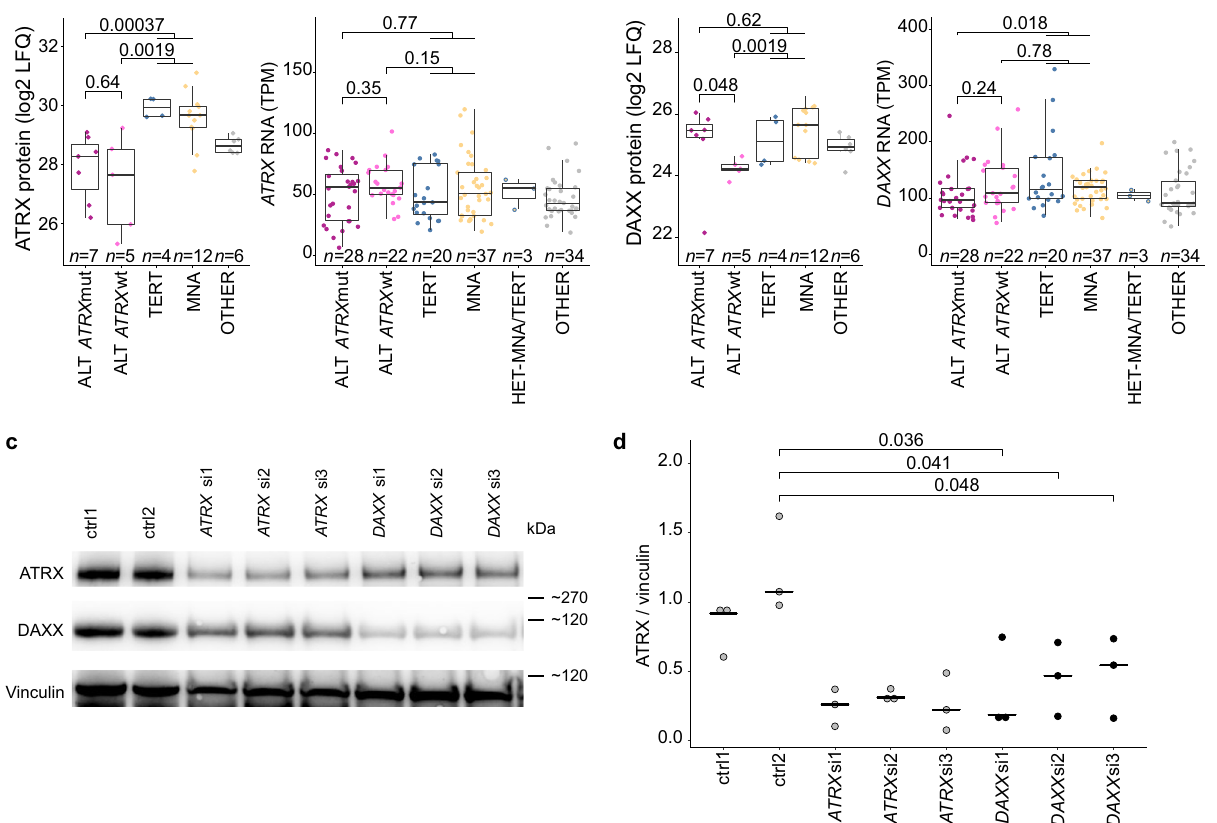
Fig. 5 ATRX/DAXX complex abundance. a ATRX protein and ATRX mRNA expression in ALT ATRX -mutated (dark pink) and wild-type (light pink) tumors compared to TERT (blue), MNA (yellow), and OTHER (gray). b Boxplots of DAXX protein and DAXX mRNA expression in ALT ATRX -mutated (dark pink) and wild-type (light pink) tumors compared to TERT (blue), MNA (yellow), and OTHER (gray). a , b Boxplots indicate the median value (middle line) and the 25th and 75th percentiles (box). The upper/lower whisker spans from the hinge to the largest/smallest value (values expanding a distance of 1.5 x inter quartile range are not considered). Dots represent individual tumors. P values in boxplots were calculated with two-sided Wilcoxon rank sum tests. n describes the number of analyzed tumors. c , d ATRX protein expression in NBL-S cells (with moderate MYCN expression) after 96 h treatment with siRNAs against DAXX (black). ATRX siRNAs as well as two negative control siRNAs were used as controls (gray). Exemplary western blot ( c ) and quanti fi cation of three biological replicates ( d ) is shown. P values calculated using a two-sided Student ’ s t -test. Horizontal line shows median value. Dots represent biological replicates. Uncut images of all biological replicates are shown in the source data fi